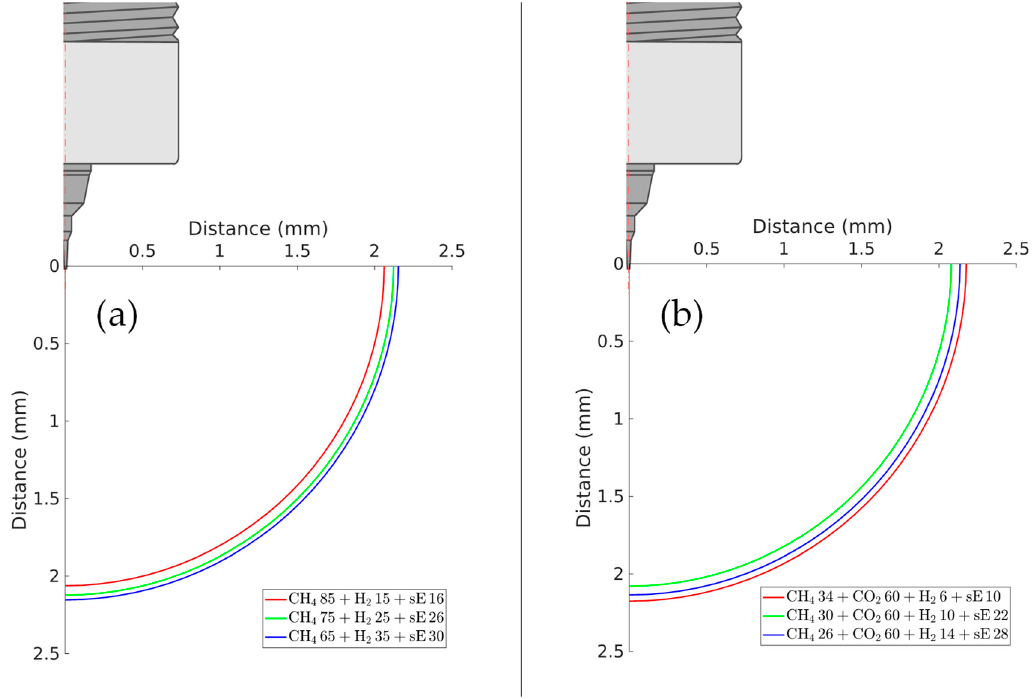
Figure 9. Representation of the simulated discharge sphere at the ignition time in maximum EGR stable dilution conditions for increasing hydrogen content. Biogas-based hydrogen levels on the left ( a ) and methane-based hydrogen blends on the right ( b ). In the legend, sE indicates the %wt value of EGR applied.